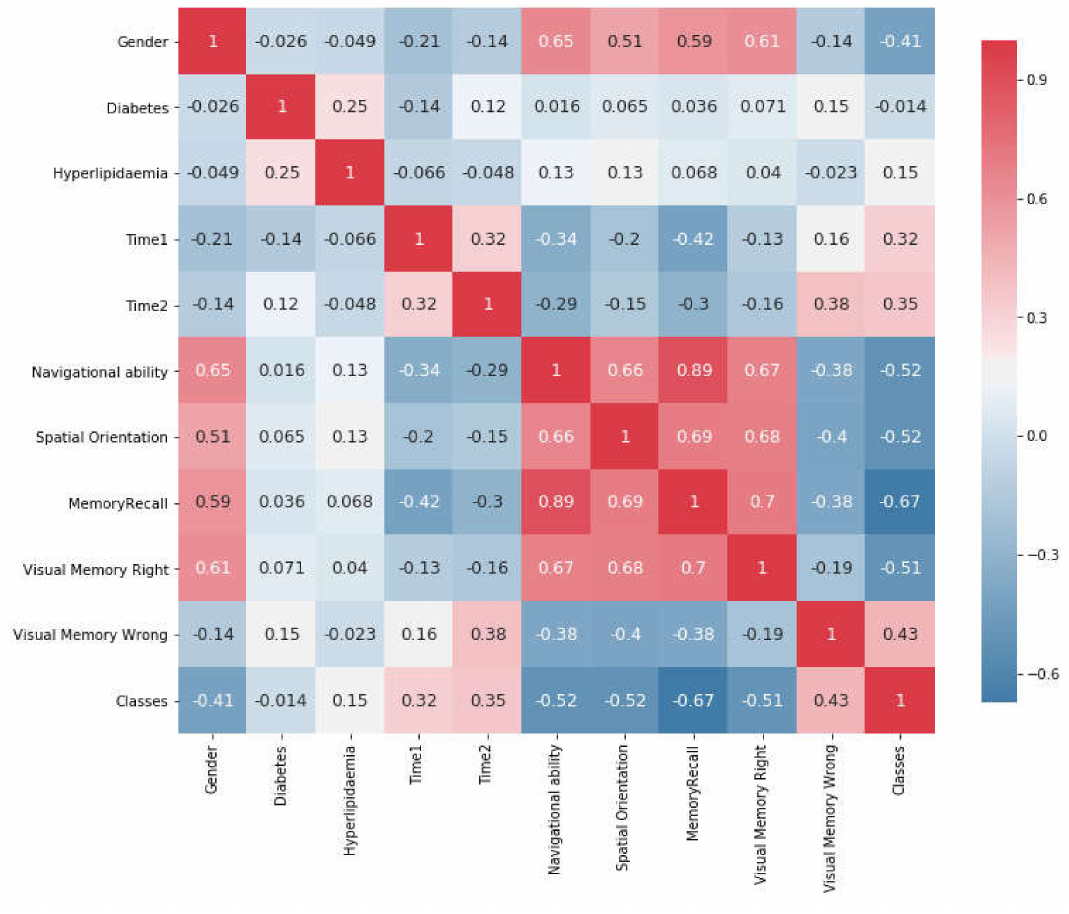
Figure 6. Correlation Matrix Plot Between Attributes